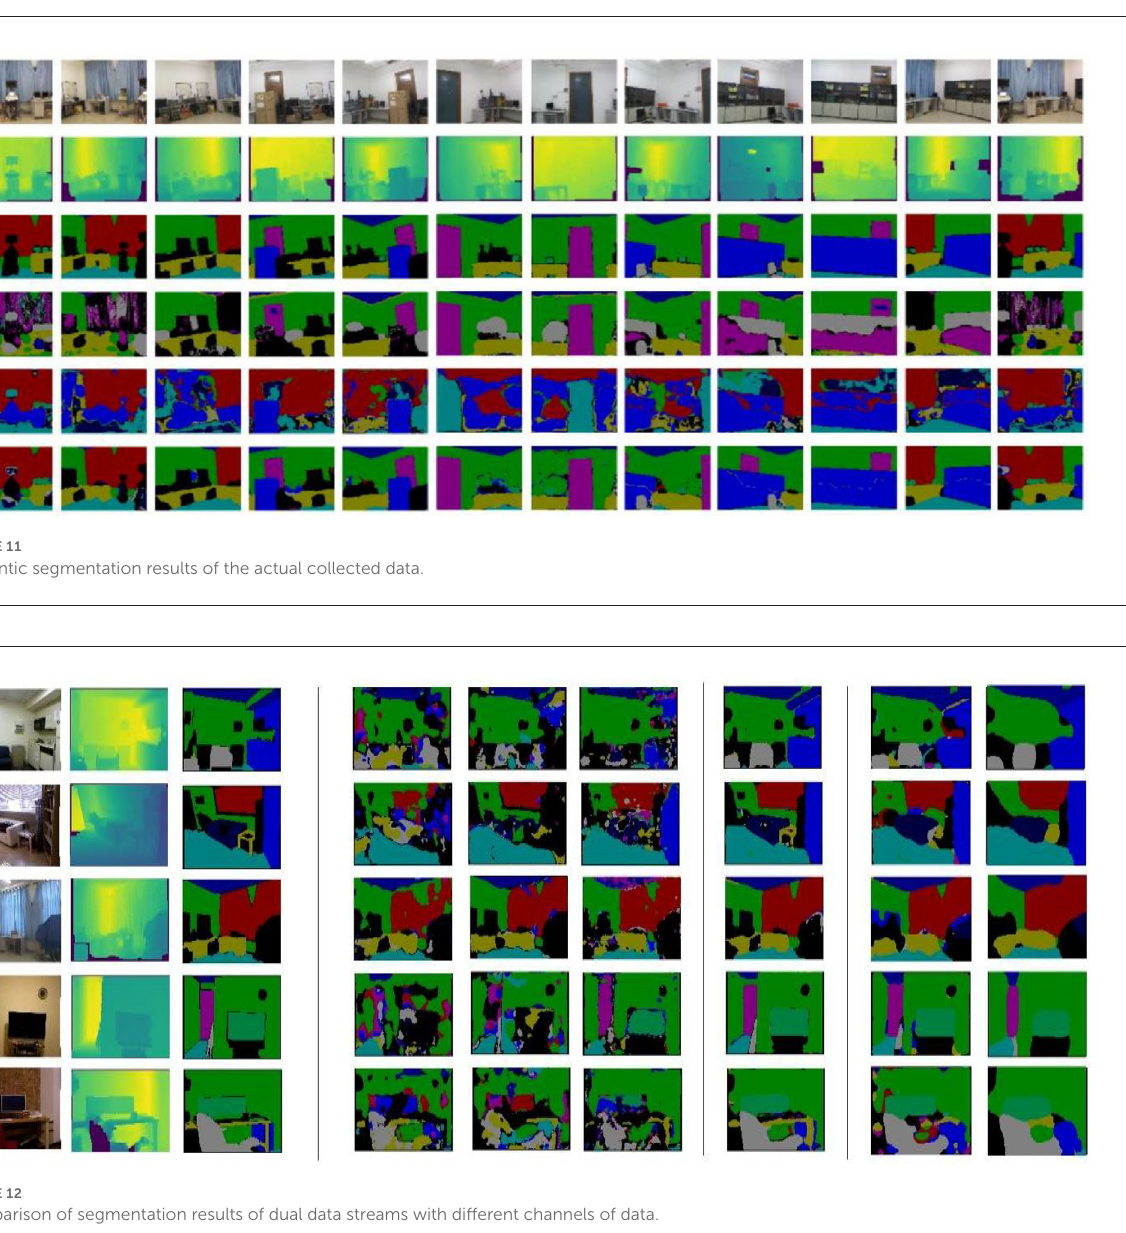
FIGURE12 Comparison of segmentation results of dual data streams with different channels of